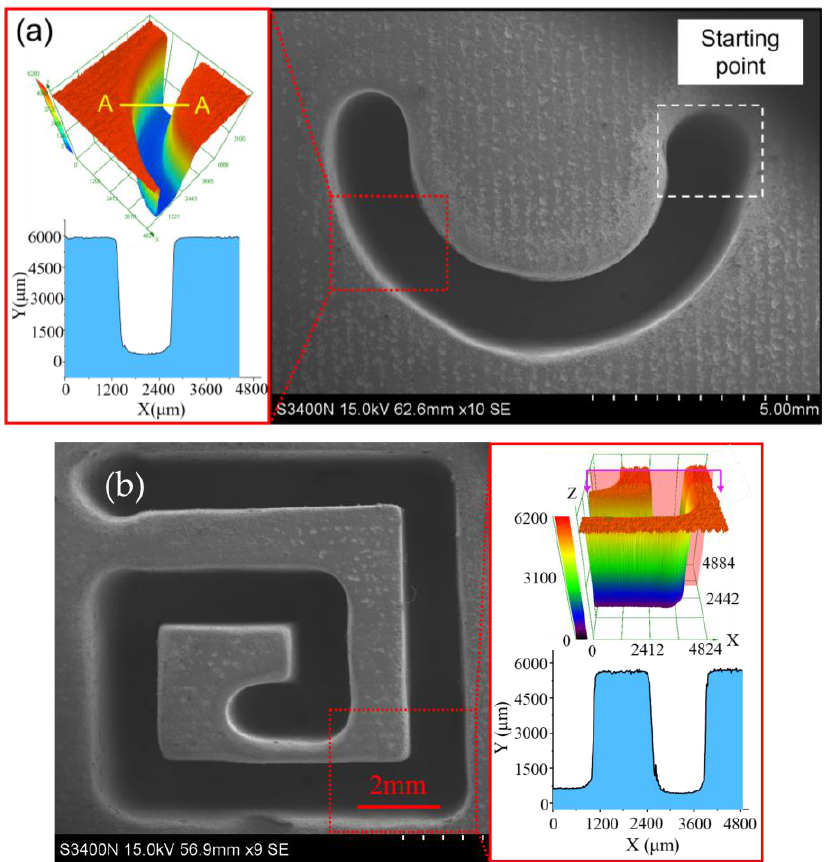
Figure 18. The SEM of complex DNG structures: ( a ) a semi-circular arc DNG structure and ( b ) a linear DNG structure.